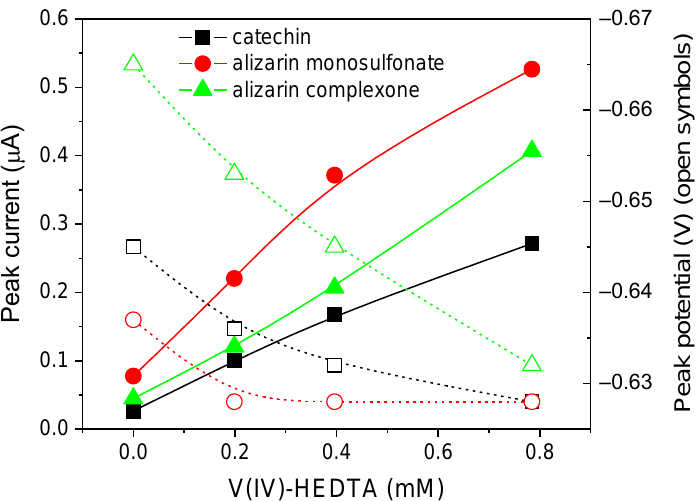
Figure 13. The influence of V(IV)-HEDTA concentration on DP peak current and peak potential of Ge(IV) for solutions containing 5 µM of catechin, 5 µM of alizarin sodium monosulfonate or 5 µM of alizarin complexone. Examined solution: 50 µM Ge(IV), 0.1 M acetate buffer (pH = 4.24). The HMDE electrode served as the working electrode.